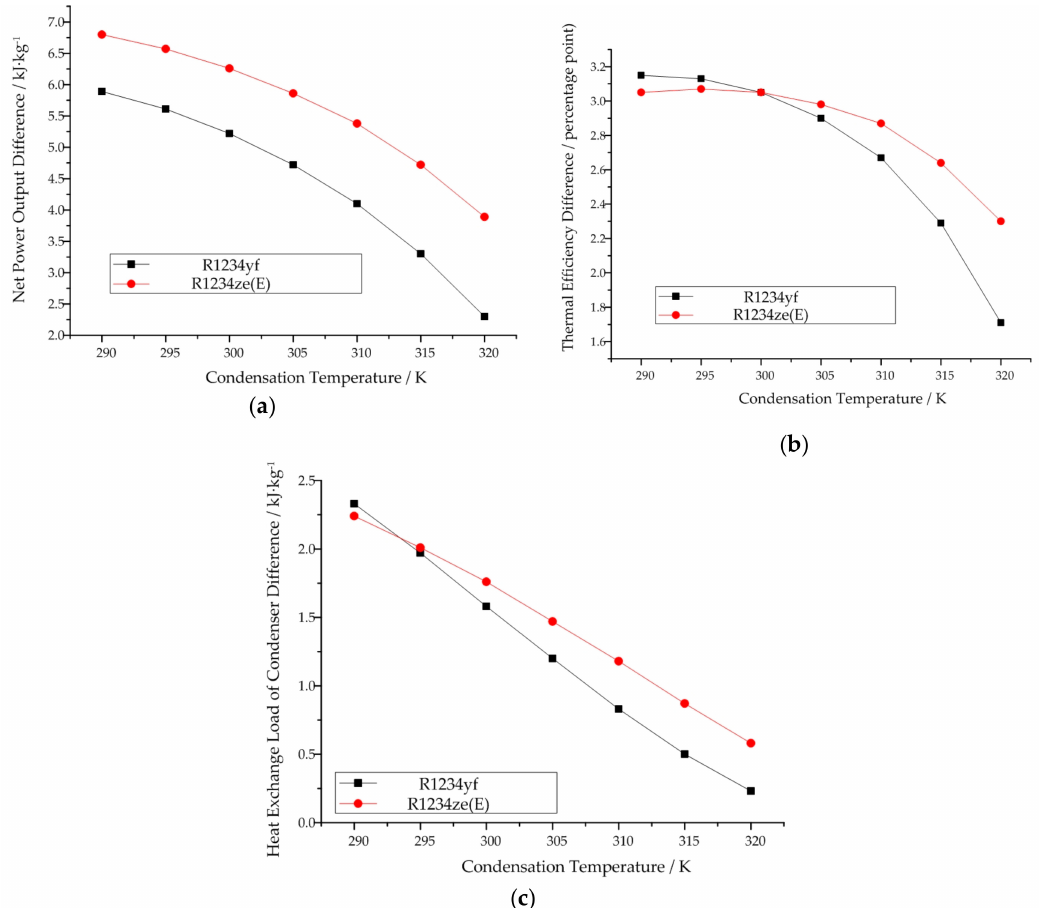
Figure 11. Variation in the di ff erence in thermodynamic performance with increasing condensation temperature in the transcritical cycle model when the condensation temperature is known: ( a ) net power output, ( b ) thermal e ffi ciency, ( c ) heat exchange load of the